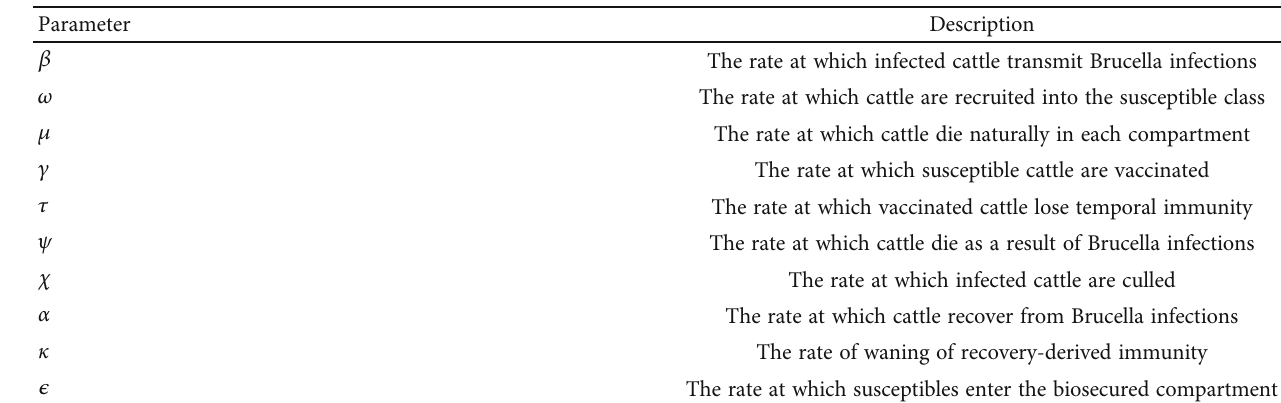
Table 1: Description of the model parameters.